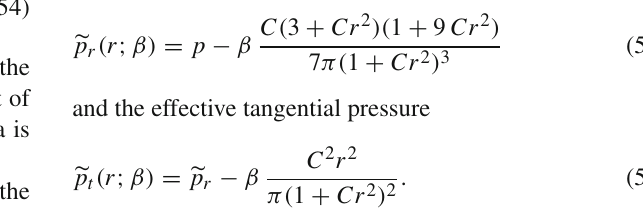
(dashed red line) and β = − 0 . 3 (dotted cyan line) represent two anisotropic solutions. The second set of curves shows the anisotropy over the pressure, (cid:2) p r (cid:6)= (cid:2) p t for β = − 0 .